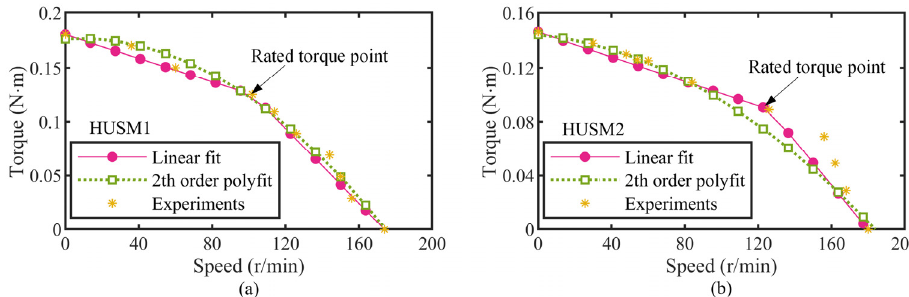
Figure 8. Performance of two HUSMs. ( a ) HUSM1; ( b )